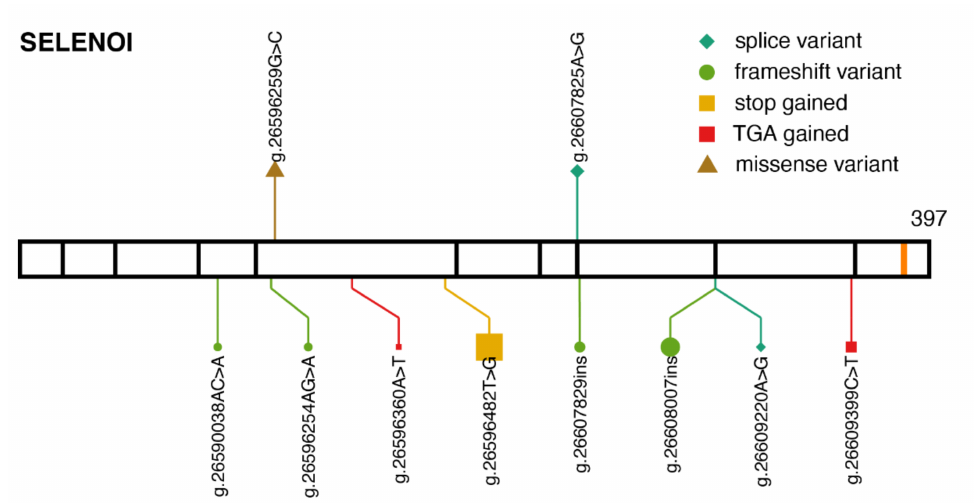
Figure 4. Pathogenic variants and protein-truncating variants in SELENOI. Location of ClinVar pathogenic variants (above) and gnomAD protein-truncating variants (below), along the SELENOI protein sequence. The same aesthetics as Figure 1b are used. SELENOI transcript: